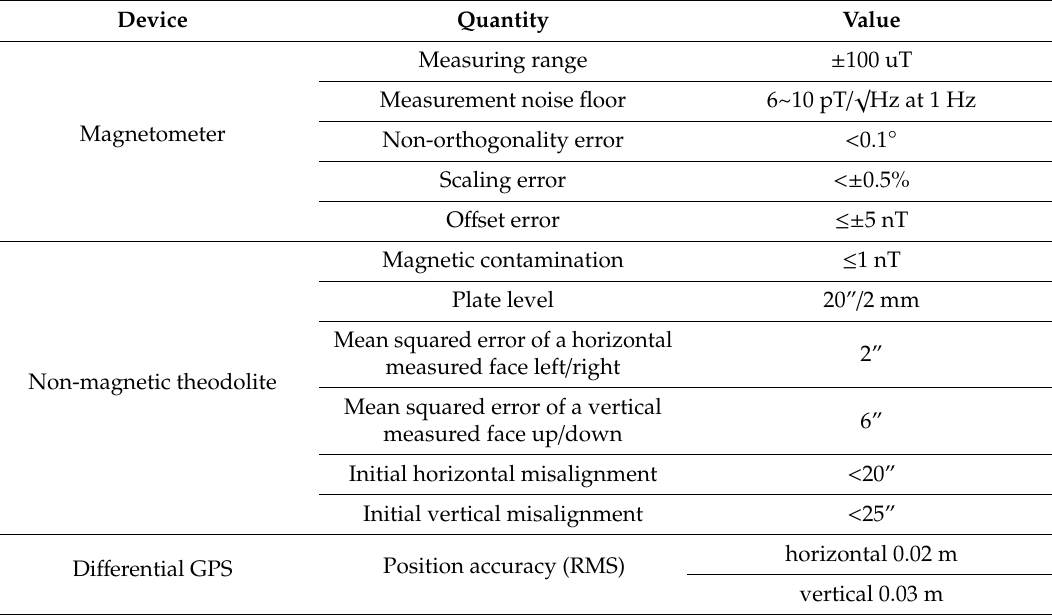
Table 1. Performance specifications of experimental devices